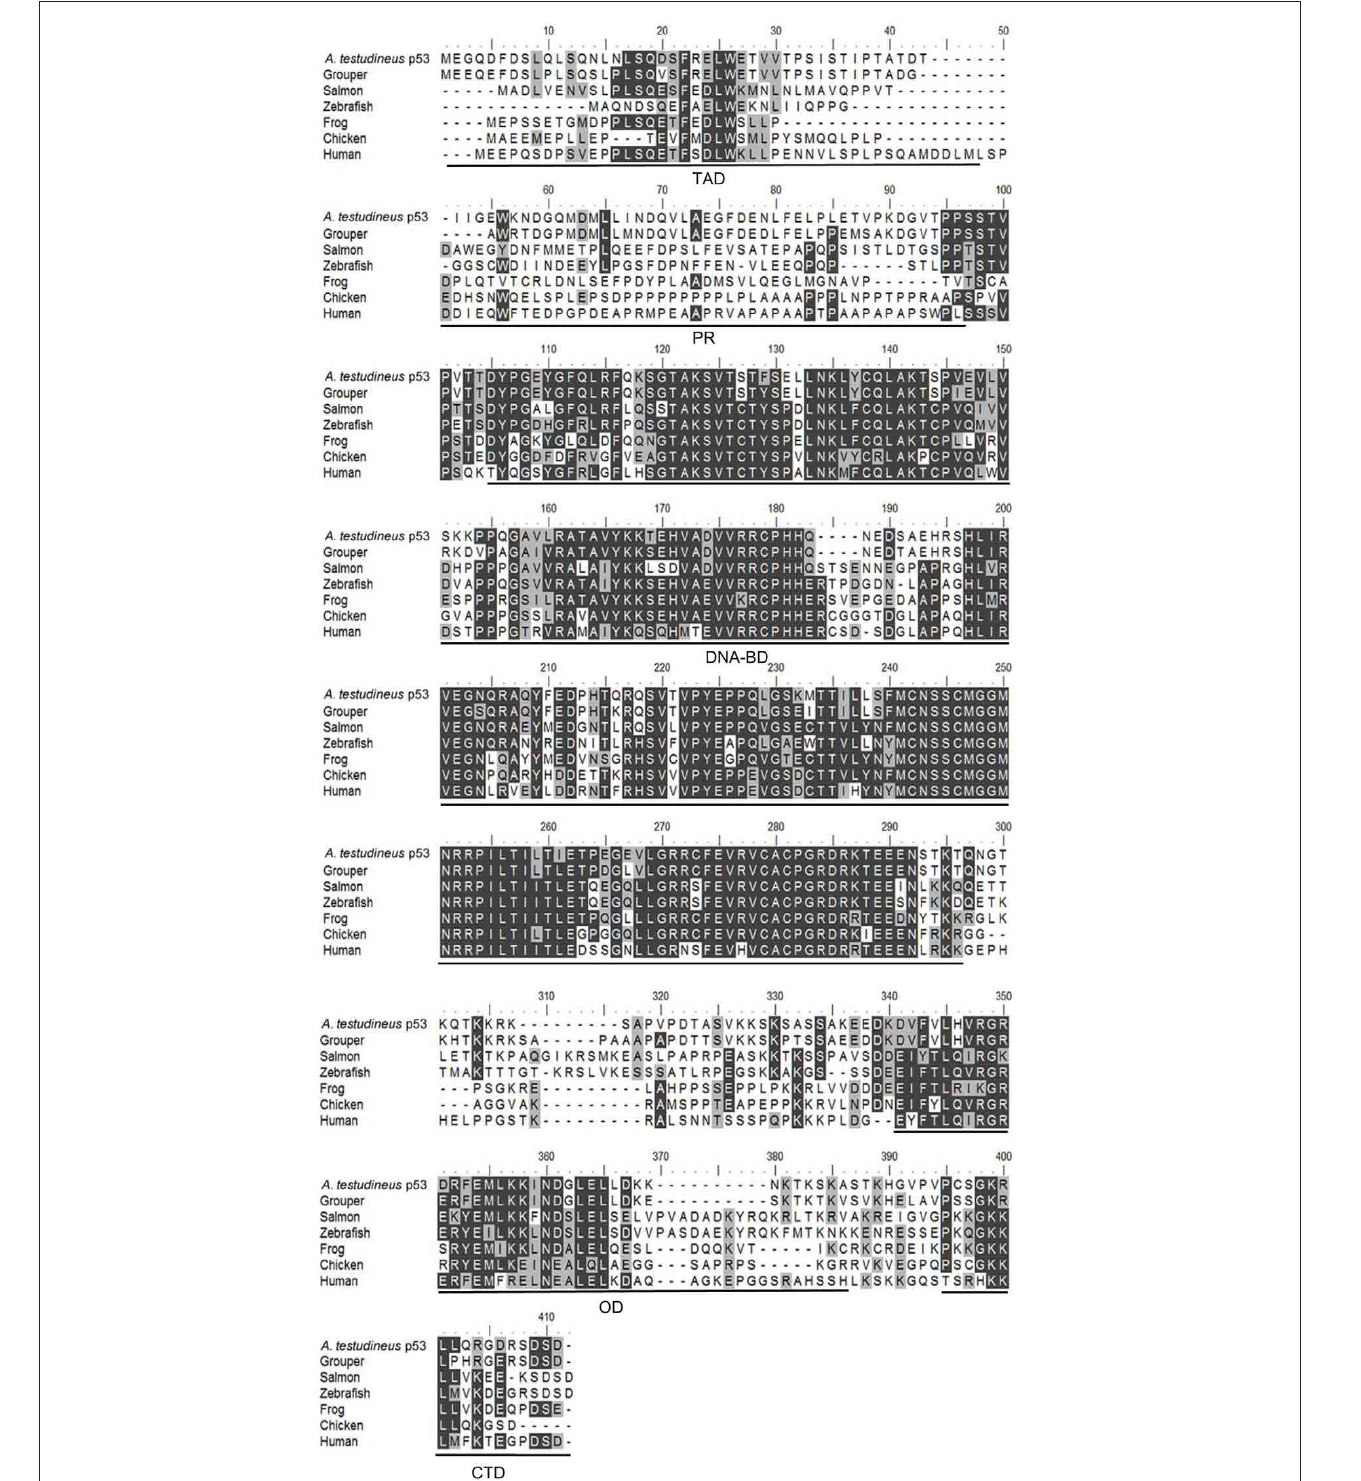
FIGURE 3 | A multiple alignment of the deduced amino acid sequence of p53 from gills of Anabas testudineus (Genbank accession number KC513732) with those from Epinephelus coioides (grouper; ADN04912.1), Oreochromis niloticus (tilapia; ADE21938.1), Xiphophorus maculatus (platyfish; AAC31134.1), Salmo salar (salmon; ACN10490.1),